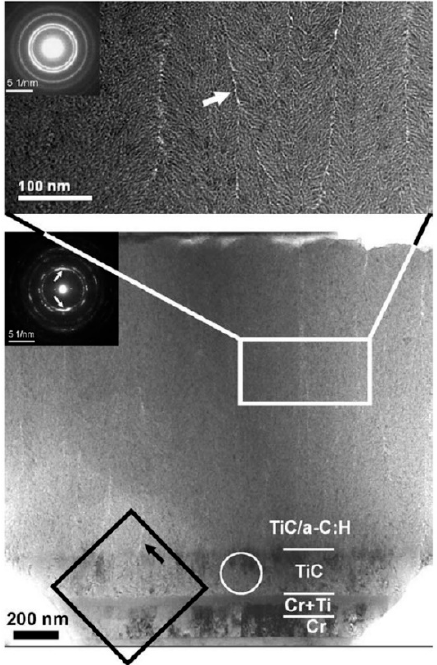
Figure 8. Cross-sectional TEM image of the TiC / diamond-like carbon (DLC) nanocomposite film deposited on steel substrate through a Cr / Ti / TiC graded interlayer. (Reproduced with permission from [81]).